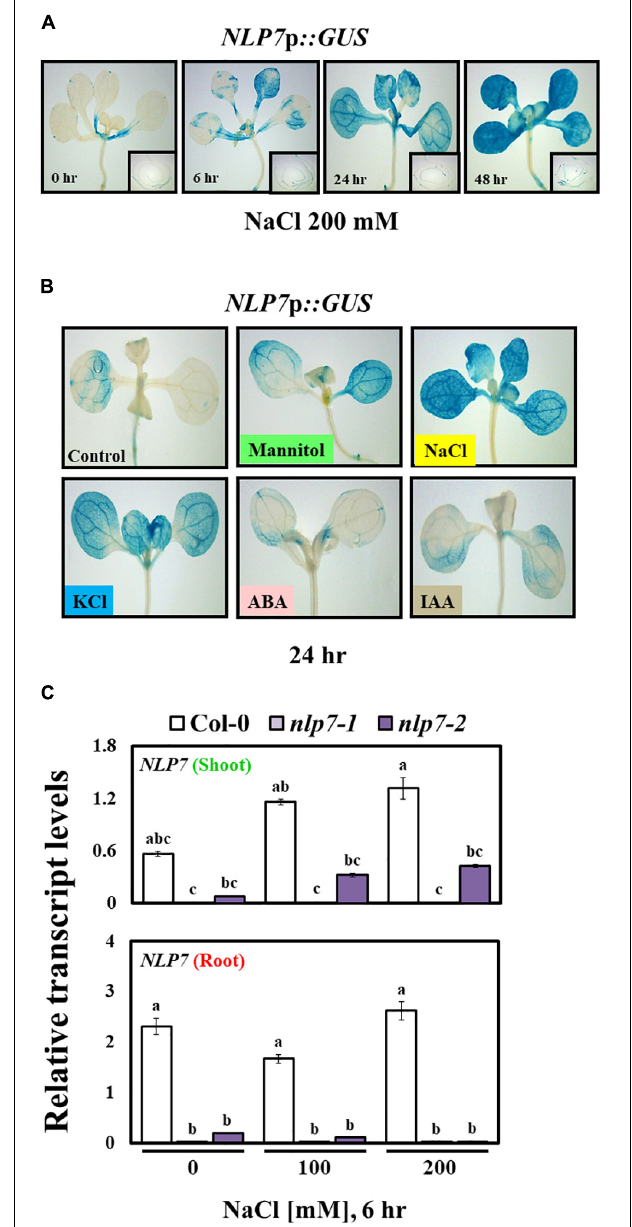
FIGURE 3 | NLP7 promoter activity was induced by salt, mannitol, and KCl. (A) Histochemical β -glucuronidase (GUS) staining of transgenic Arabidopsis seedlings harboring the NLP7 p ::GUS fusion construct. The seedings were germinated and grown on half-strength MS medium containing 5 mM KNO 3 for 9 days and then treated with 200 mM NaCl for 0, 6, 24, or 48 h. (B) Histochemical GUS staining of the 9-day-old seedlings grown on a nitrogen-free half-strength MS medium containing 5 mM KNO 3 in response to 300 mM mannitol, 200 mM NaCl, 200 mM KCl, 5 µ M ABA, and 0.5 µ M IAA for 24 h; untreated seedlings were used as controls. (C) Relative transcript levels of NLP7 in the shoots and roots of 9-day-old Col-0, nlp7-1 , and nlp7-2 seedlings following exposure to 0, 150, or 200 mM NaCl for 6 h. AtActin2 was used as the internal control. Error bars represent the standard deviation of three independent replicates. Different letters (a, b, or c) within a treatment group indicate significant differences in the two-way ANOVA ( P ≤ 0.05, Tukey’s